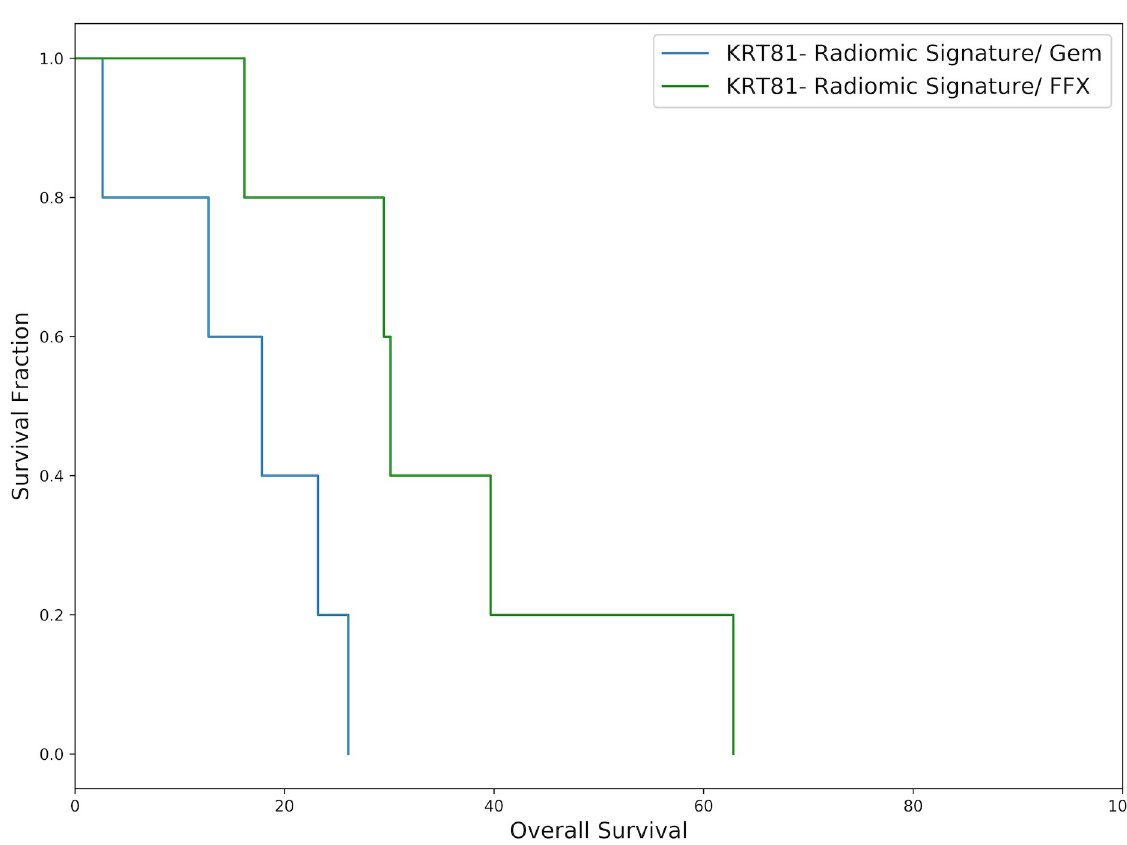
Fig 7. Exemplary Kaplan-Meier plot of patients with a predicted KRT81-/ low risk radiomic signature drawn from the 10 cross- validation folds and representing the median hazard ratio. Patients who received FOLFIRINOX experienced significantly improved survival, (median survival 17.83 vs 30.10 months, p = 0.01, HR = 2.57, N = 10).